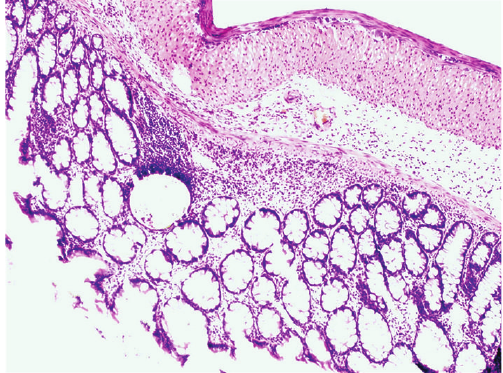
Figure 5: Pedunculated adenocarcinoma with fibrovascular stalk and heads containing dysplastic epithelial glands in colonic mucosa from a rat in the AOM group.